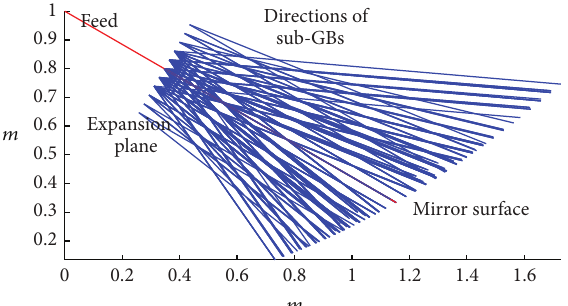
Method of Moment (PMM), which is used to analyze